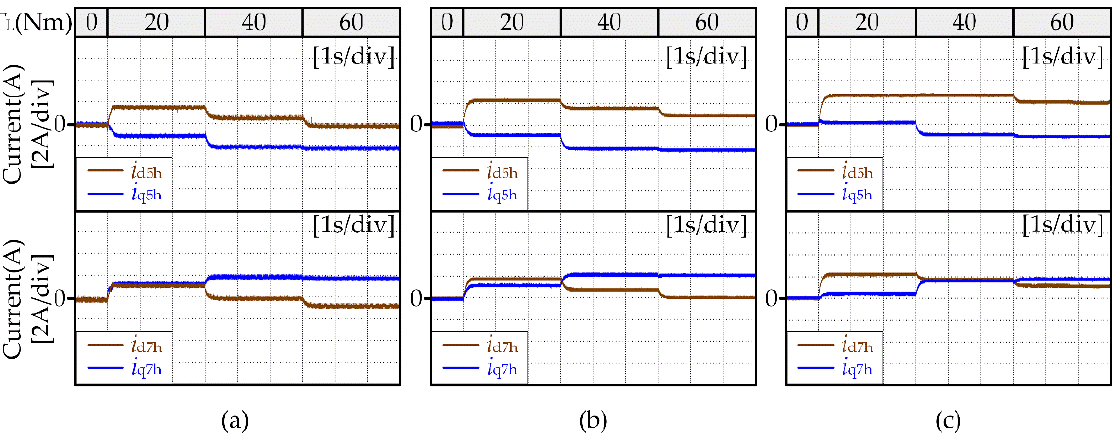
Figure 14. Waveforms of 5th and 7th current harmonic components without current harmonic suppression strategy applied. ( a ) 100 rpm; ( b ) 1000 rpm; and ( c ) 2500 rpm.